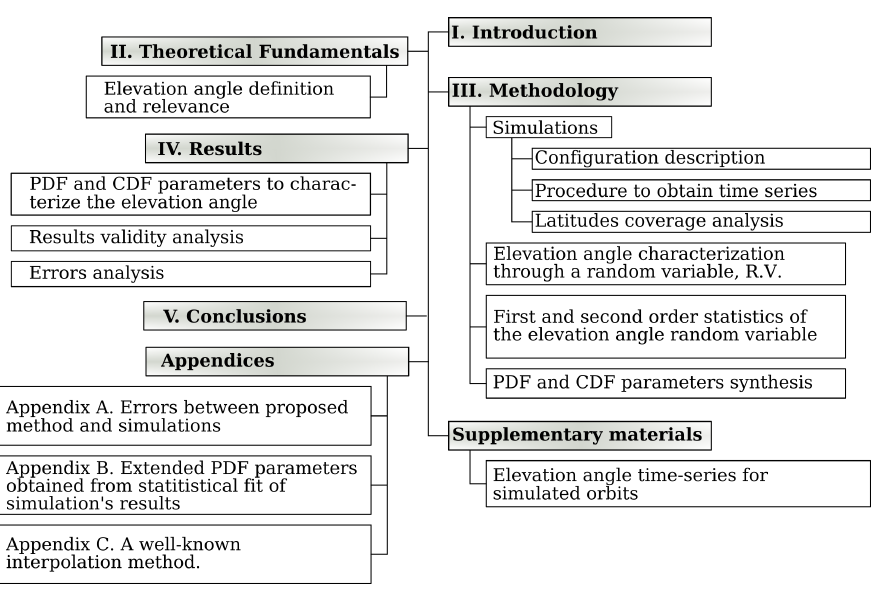
Figure 2. Basic structure and contents of this